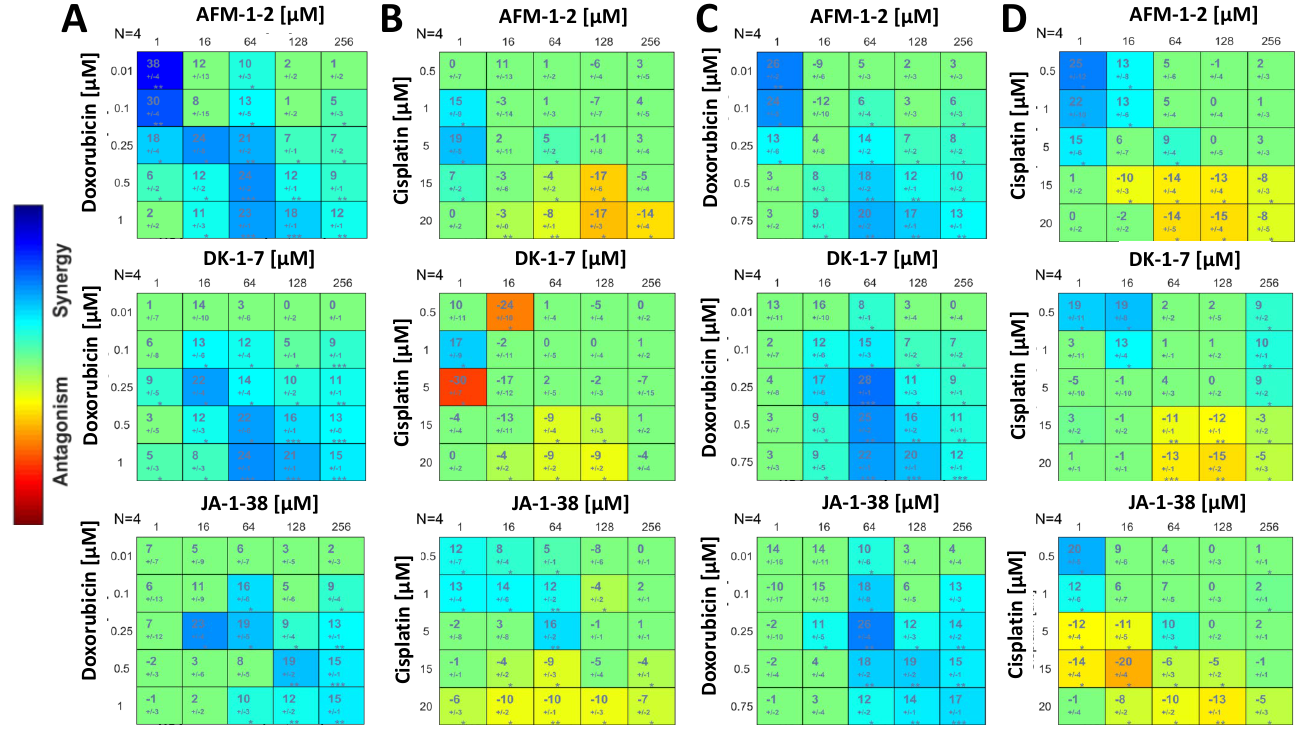
Figure 8. A synergistic effect was found between cjoc42 derivatives and doxorubicin, while an antagonistic effect was seen with cisplatin. ( A ) Dose–response plots of doxorubicin with AFM-1